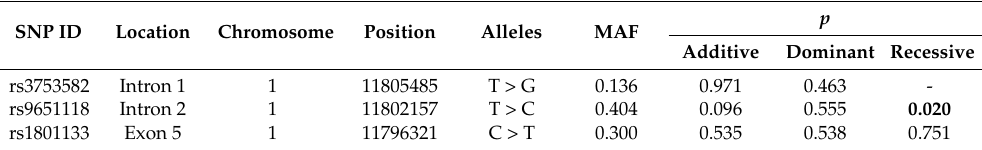
Table 1. Association between haplotype tagging SNPs in MTHFR and BCR in clinically localized prostate cancer patients treated with